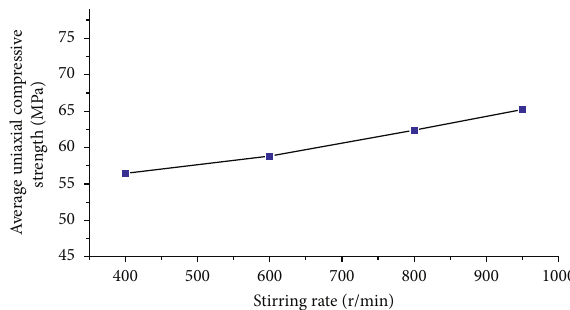
Figure 12: Average compressive strength-stirring rate relation.